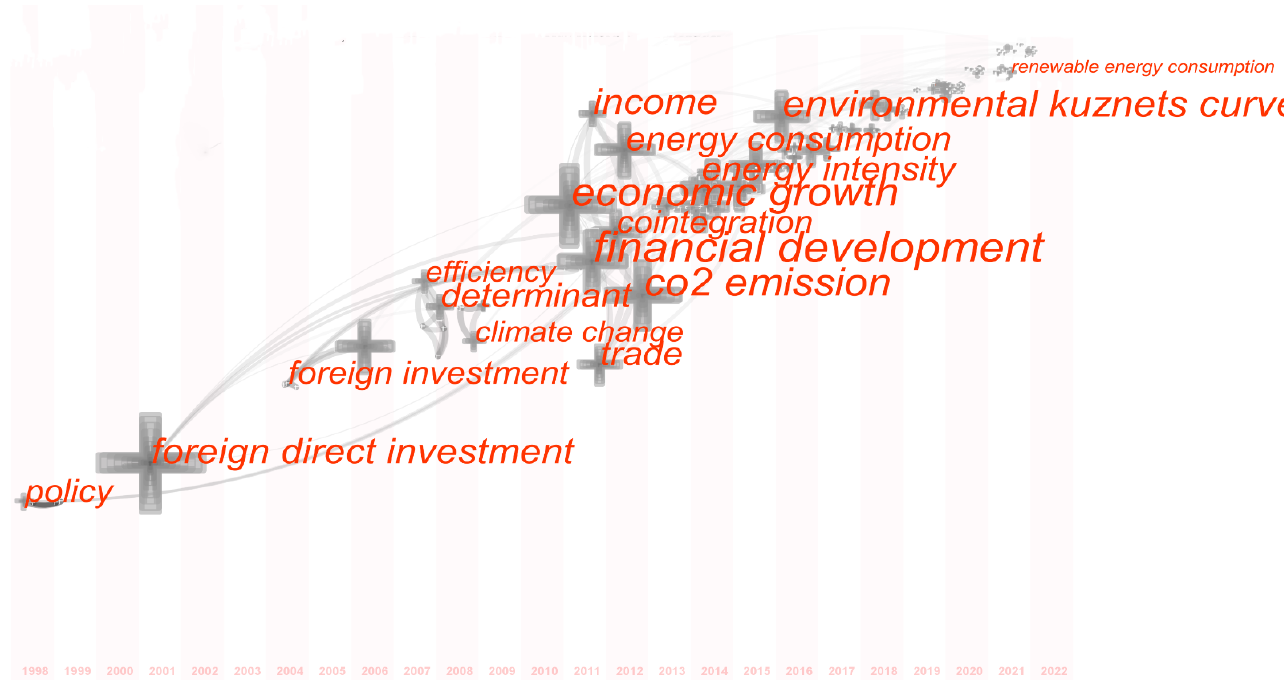
Figure 7. A timezone view of keywords evolution from January 1998 to March 2022(by Citespace).